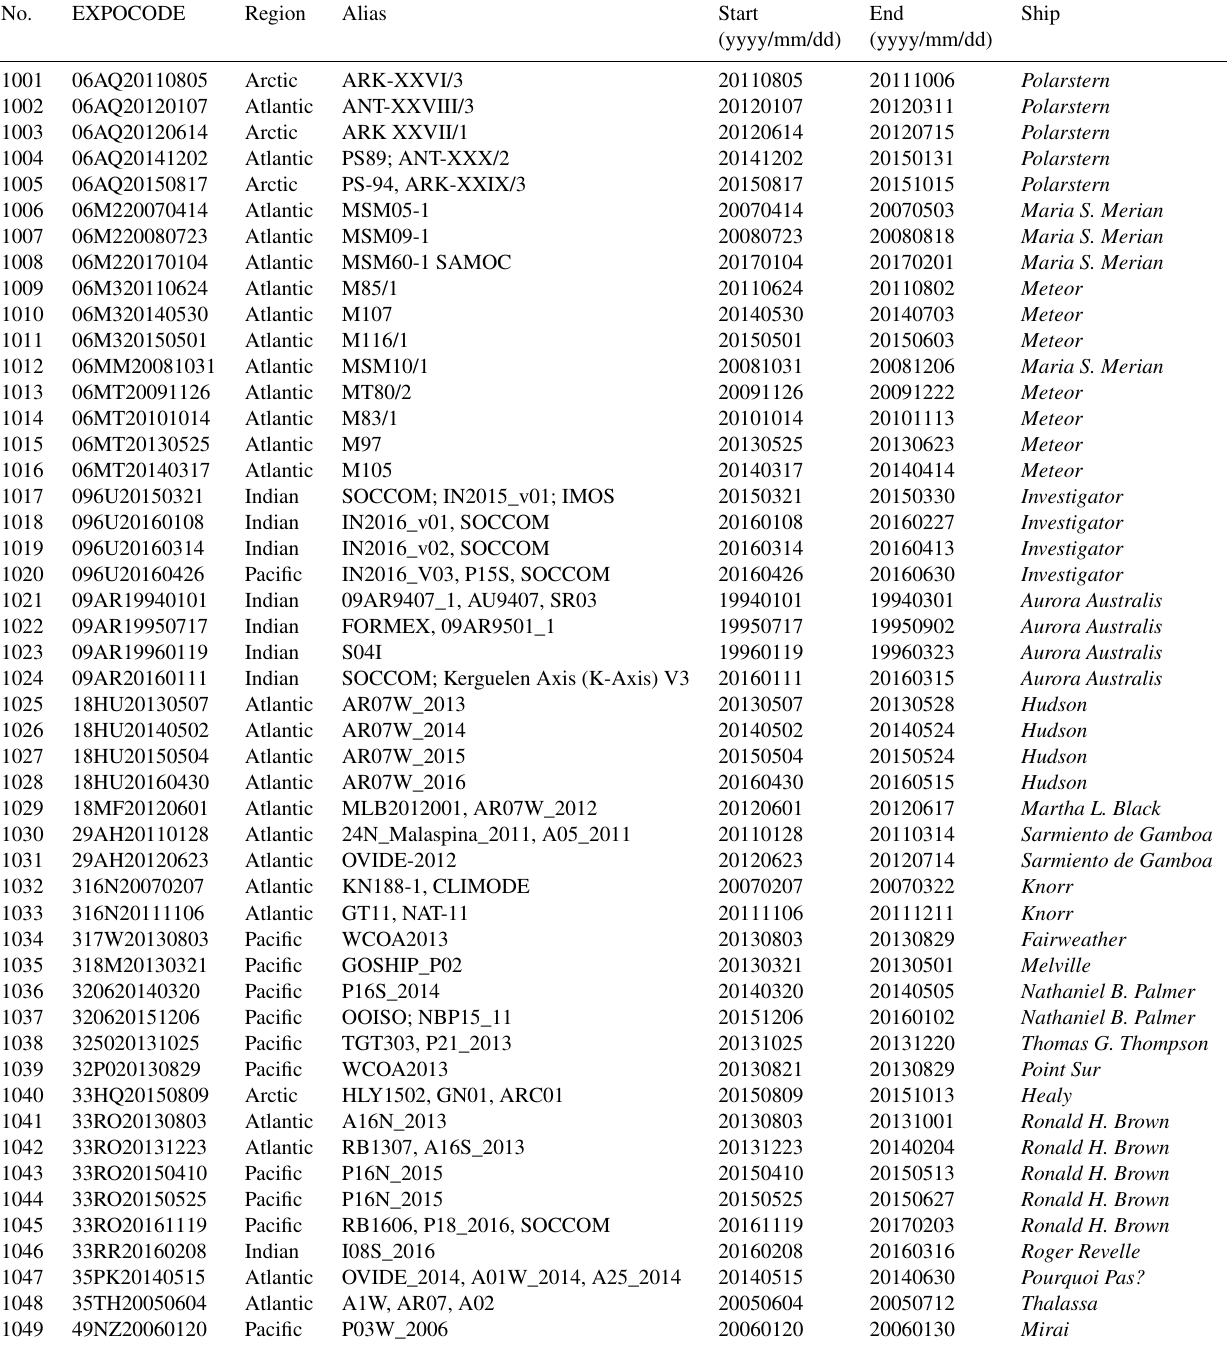
Table A1. Cruises included in GLODAPv2.2019 that did not appear in GLODAPv2. Complete information on each cruise, such as variables included and chief scientist and principal investigator names, is provided in the cruise summary table at